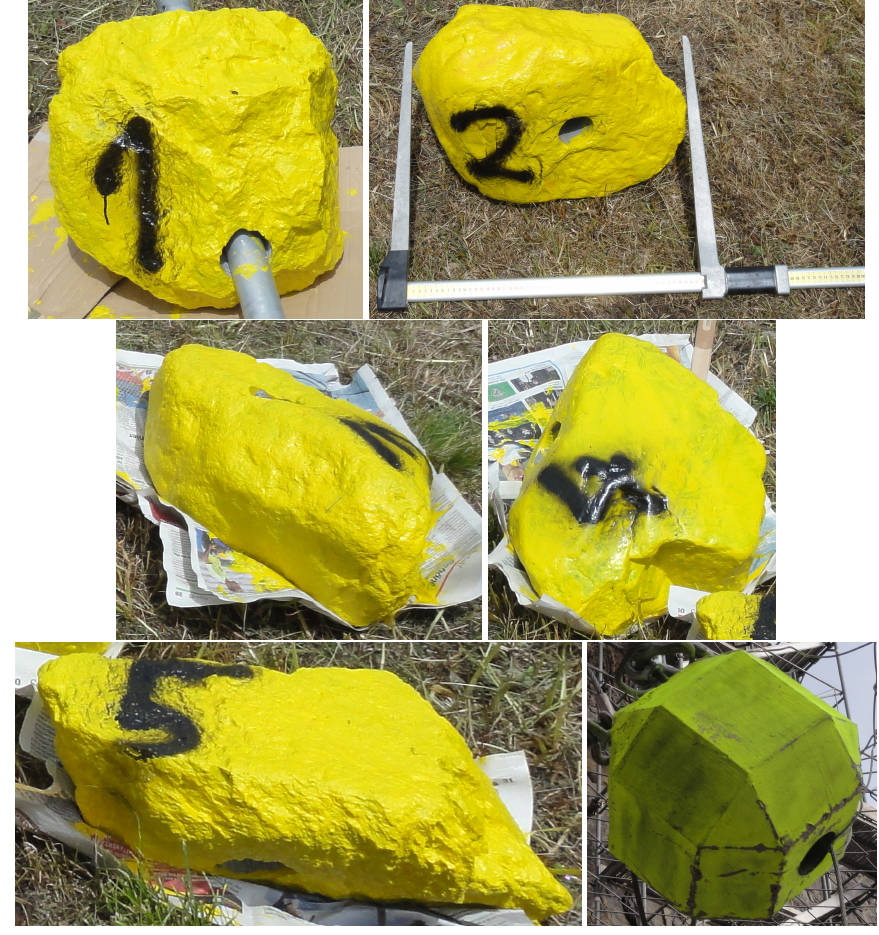
Figure 3. Rockfall test blocks 1–6. Table 2. Masses and geometrical details of test